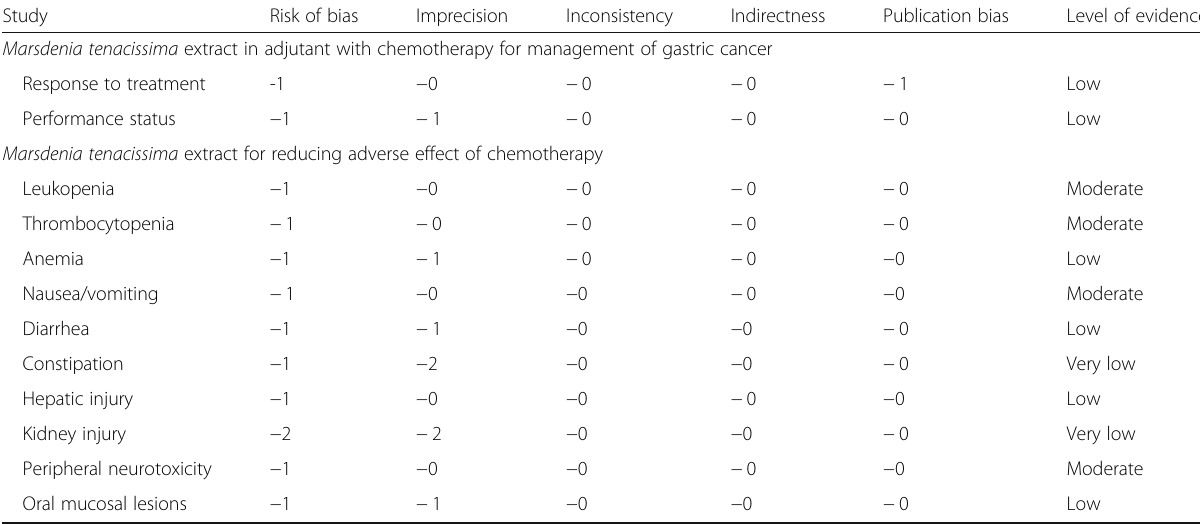
Table 3 Level of evidence assessment using GRADE approach for the outcomes Study Risk of bias Imprecision Inconsistency Indirectness Publication bias Level of evidence Marsdenia tenacissima extract in adjutant with chemotherapy for management of gastric